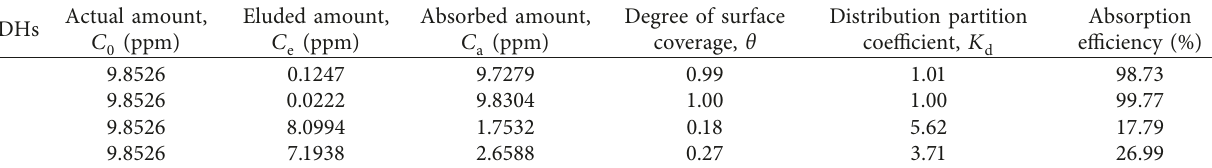
Table 1: Results of the adsorption study of Fe 2+ .